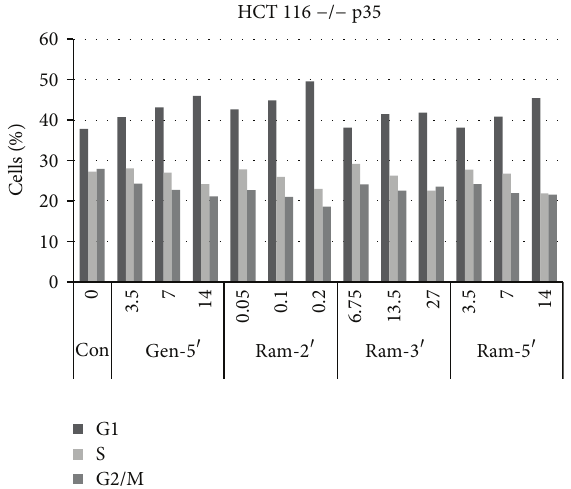
Figure 5: Cell-cycle phases distribution in HCT 116 − / − p53 cells treated with genistein derivatives substituted at C4 󸀠